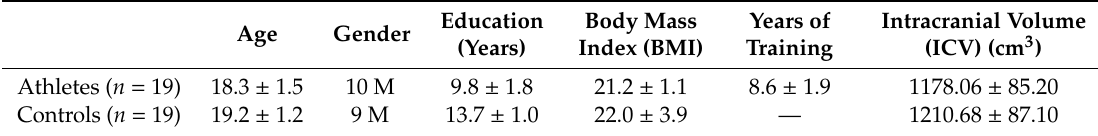
Table 1. Demographic data of athletes and controls.